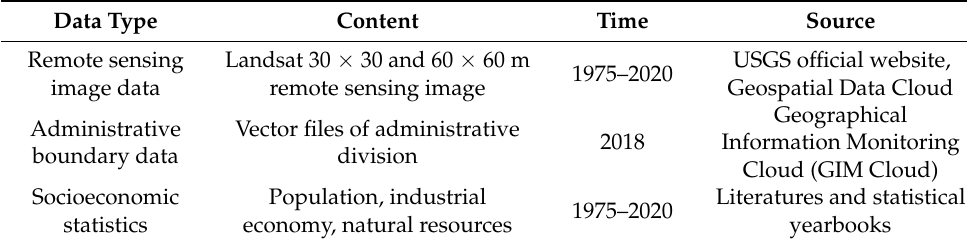
Table 1. Study data sources and